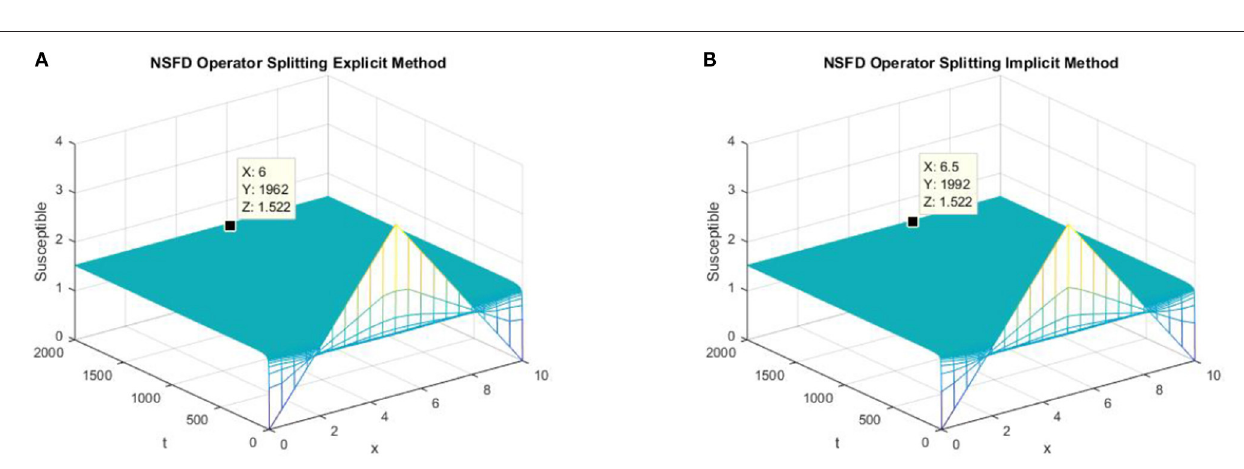
Frontiers in Physics | www.frontiersin.org